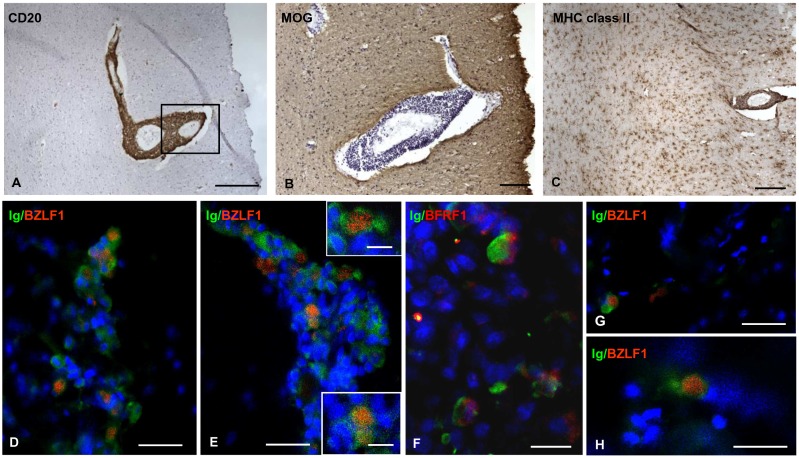
Immunohistochemical detection of BZLF-1 in acute white matter lesions of the MS brain.(A) A large, B-cell enriched perivascular immune infiltrate surrounding 3 blood vessels in an active white matter lesion of a MS case is visualized with anti-CD20 antibody. (B) Immunostaining for myelin-oligodendrocyte glycoprotein (MOG) in a serial section reveals presence of myelin. (C) The same lesion shows massive microglia/macrophage activation in the parenchyma. Sections shown in panels A–C were counterstained with hematoxylin. (D, E) Double immunofluorescence staining for Ig (green) and BZLF-1 (red) reveals the presence of several Ig+ plasmablasts/plasma cells co-expressing BZLF-1 in the portion of the perivascular cuff marked with a frame in panel A. The upper and lower insets in E show 1 and 2 Ig+ cells co-expressing BZLF-1 at high power magnification, respectively. (F) Double immunofluorescence staining for BFRF-1 (red) and Ig (green) shows presence of double labelled BFRF-1+/Ig+ cells in the same area of the perivascular cuff stained for BZLF-1 in E. (G, H) Cells double stained for Ig (green) and BZLF-1 (red) in smaller perivascular cuffs of the same active lesion shown in A–C. Bars: 200 µm in A and C; 100 µm in B; 50 µm in D, E, G; 20 µm in F and H; 10 µm in the insets in D.